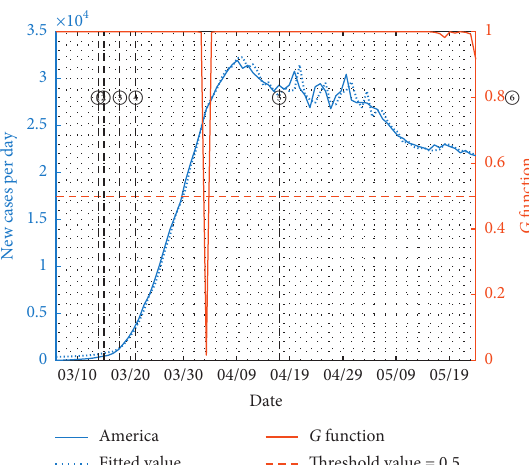
Figure 11: The fitting result of America. The left axis shows the daily confirmed cases for the real data after smoothness (blue solid line) and its fitted values by the STAR model (blue dashed line). The right axis shows the value of nonlinear functions G changing with time (orange solid line) and the reference line with threshold 0.5 (orange dashed line). The vertical dotted line indicates the sequential released policies: ① declare state of emergency and close schools, ② impose travel ban to the United Kingdom and Ireland, ③ close the border with Canada, ④ close the border with Mexico, and ⑤ restart the US economy in three stages.